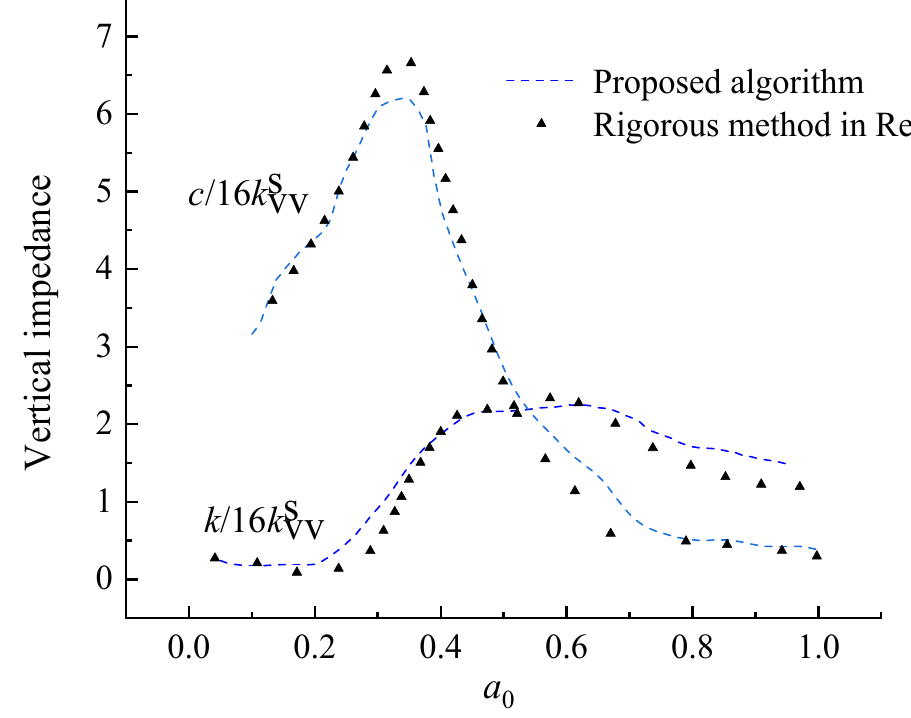
Figure 5. Vertical impedance function of pile-group foundation compared with a rigorous method.